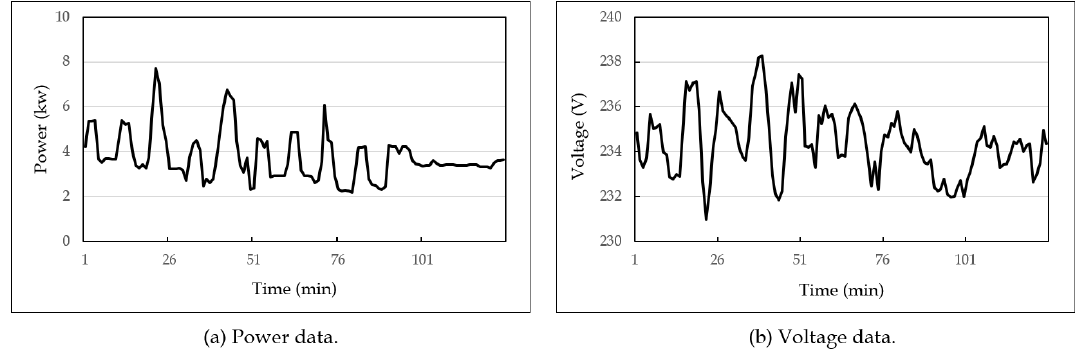
Figure 6. An example part of power consumption data used in the